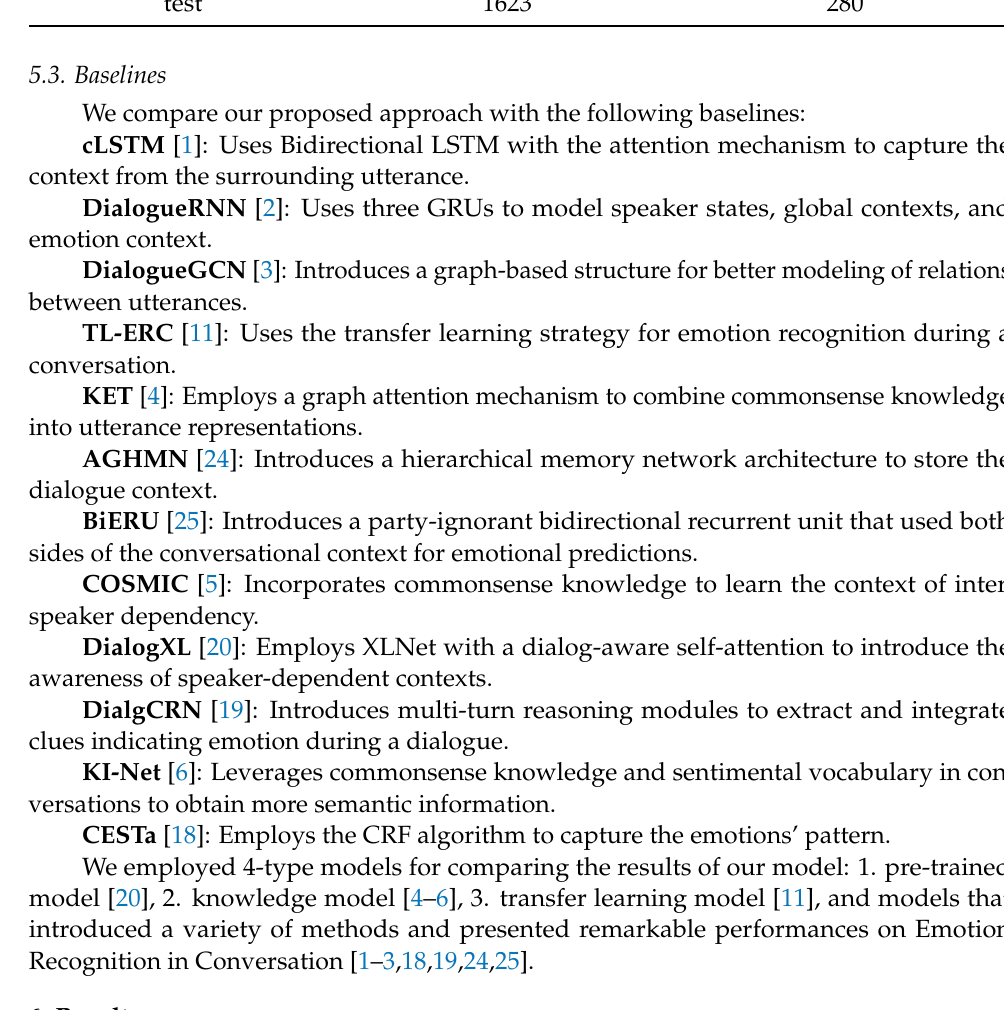
Table 3. MELD dataset split. MELD Utterances Dialogues